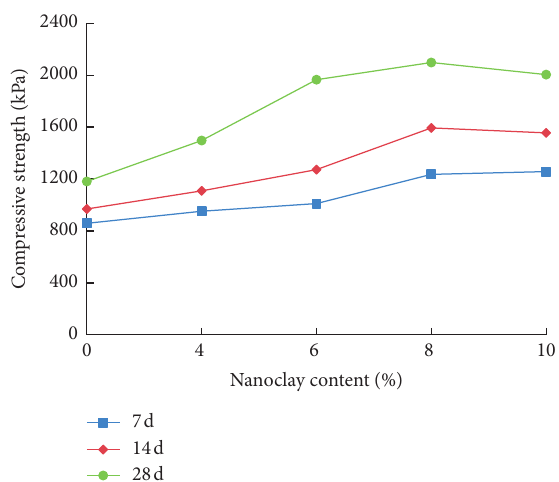
Figure 11: The relationship between the nanoclay content and the comprehensive strength.